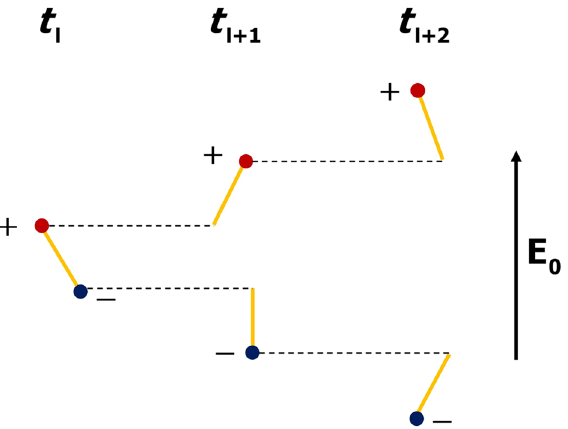
Figure 4. Simplified illustration of the scheme of relay charge transfer along an ambient electric field direction shown for three consecutive moments of discrete model time. Each model link arising between a pair of neighboring nodes creates dipole charge separation. Amplitudes of divided positive and negative charges, shown as red and blue dots, respectively, are assumed to be equal. The resulting current is directed along an ambient electric field